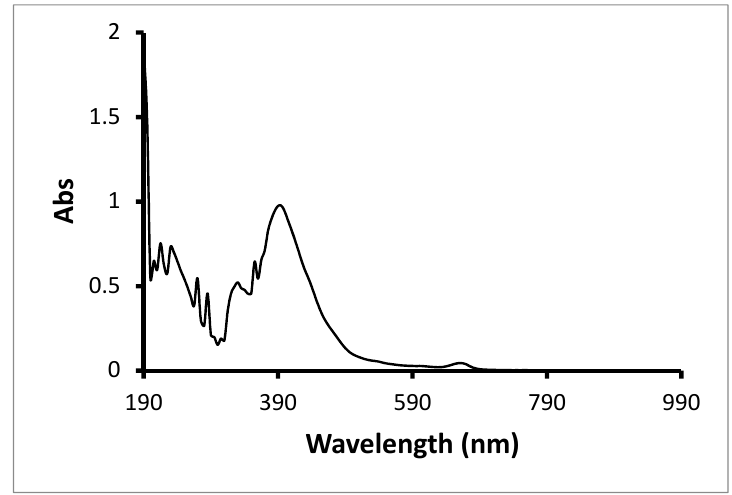
Figure 7. UV-Vis spectrum of the M. oleifera leaves extract.